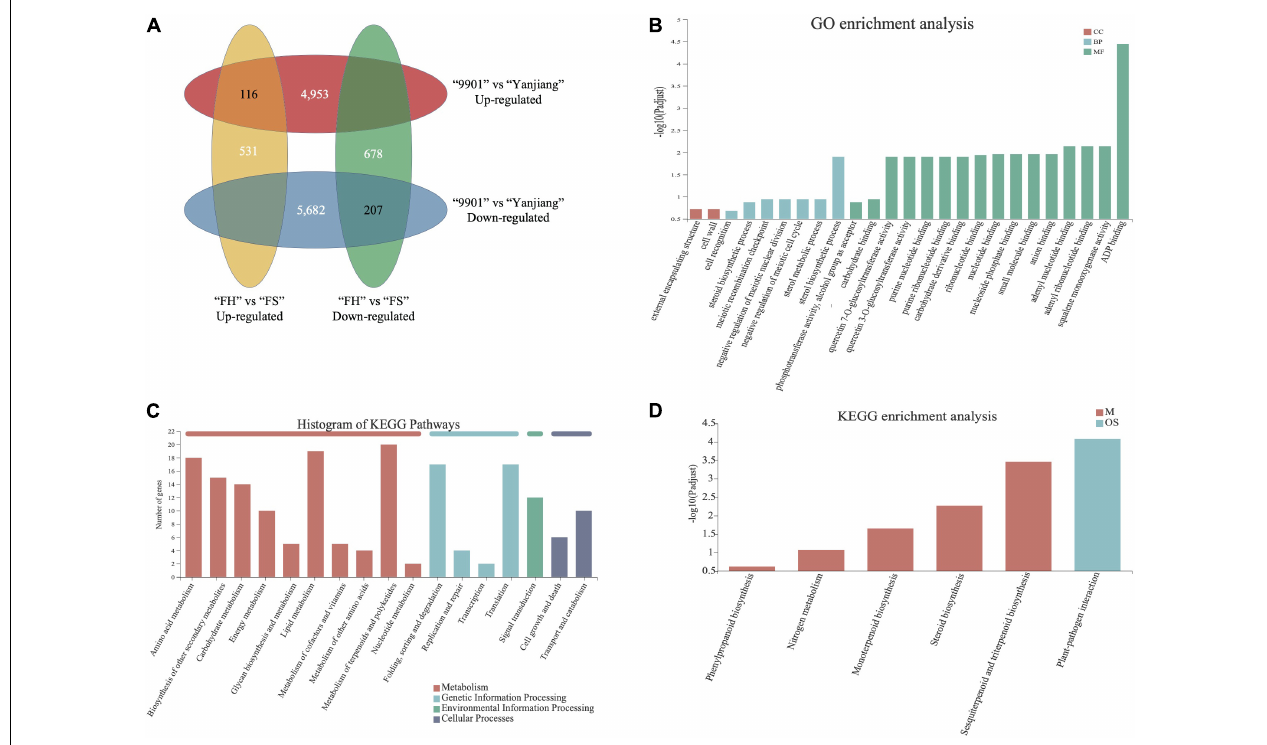
FIGURE 4 | GO and KEGG analysis of differentially expressed genes (DEGs). (A) Venn analysis of DEGs. (B) GO enrichment analysis of 323 DEGs. (C) Statistics analysis of KEGG pathway among the 323 DEGs. (D) KEGG enrichment analysis of 323 DEGs.